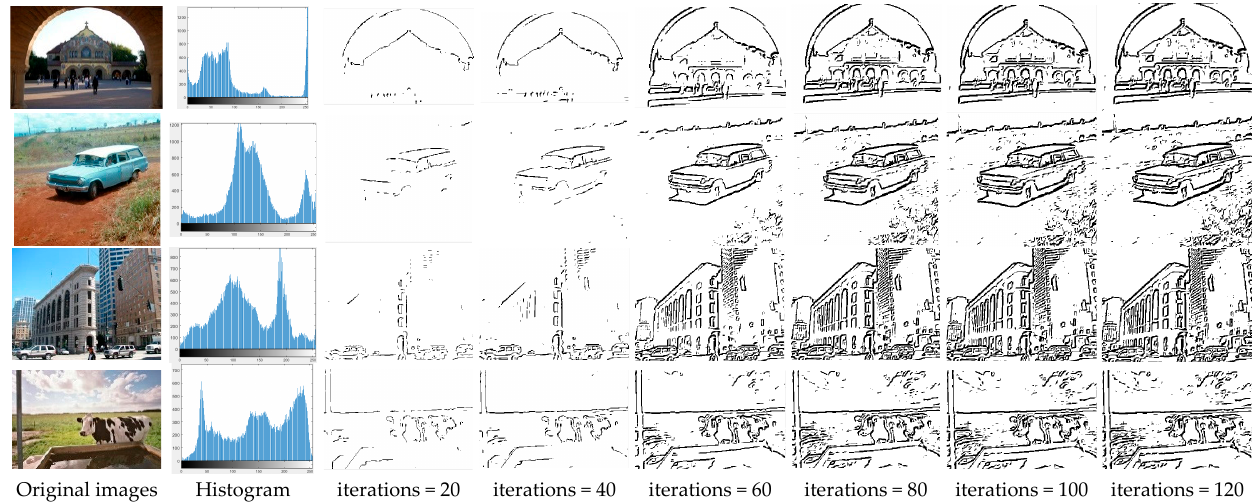
Figure 4. The test results of the proposed algorithm on the Stanford background dataset.